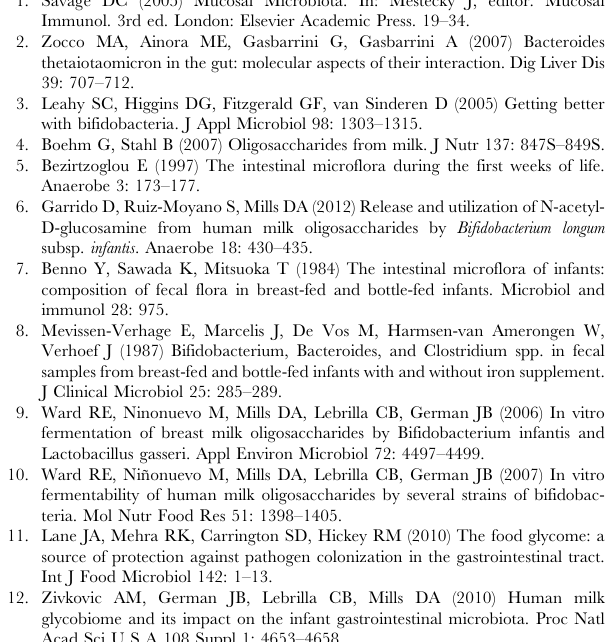
(TIF) Figure S4 Transcription (fold-change) of the genes in the HMO-utilisation cluster (blon_2331-blon_2361) fol- lowing exposure to the three oligosaccharide treat- ments. 3 9 sialyllactose (white shading); 6 9 sialyllactose (black and white diagonal shading); 3 9 - and 6 9 -sialyllactose mixture (black shading). (TIF) Table S1 Selected genes, primers, and probes for qPCR. (DOC) Table S2 List of genes differentially regulated by 3 9 sialyllactose treatment. (DOC) Table S3 List of genes differentially regulated by 6 9 sialyllactose treatment. (DOC) Table S4 List of genes differentially regulated by treatment with a mixture of 3 9 - and 6 9 -sialyllactose. (DOC) Table S5 List of common genes up-regulated by 6 9 sia- lyllactose and the mixture of 3 9 -and 6 9 -sialyllactose.